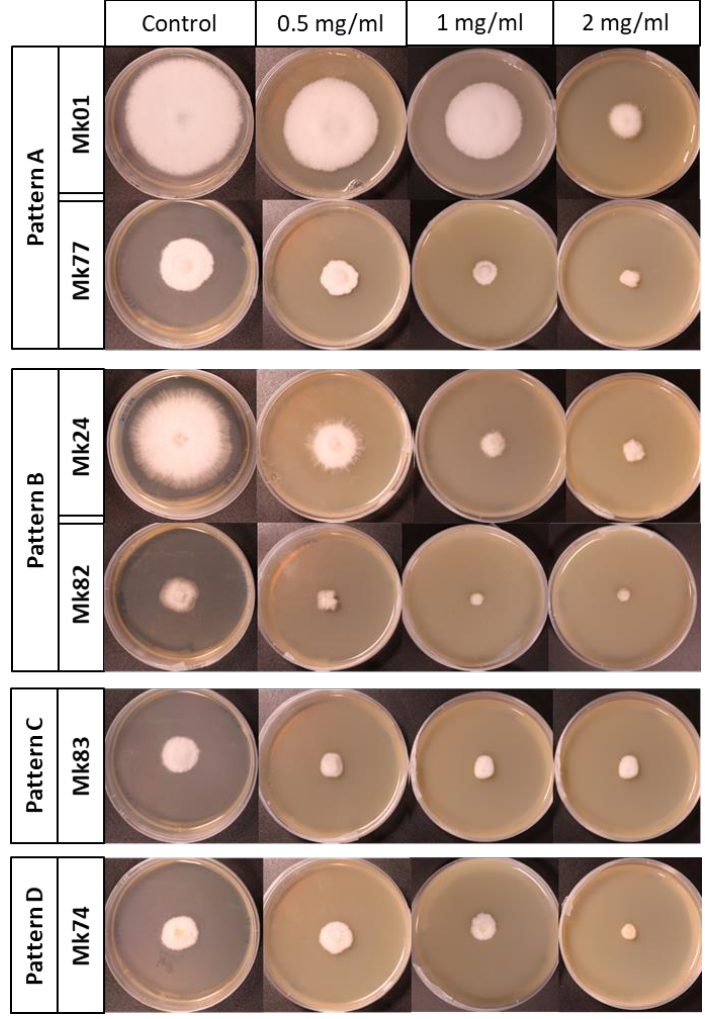
Figure 5. Growth patterns of monokaryons of the F- and S-subpopulations growing for 10 days on control medium (MESM) and MESM plus different doses of chitosan (0.5, 1, and 2 mg/mL).